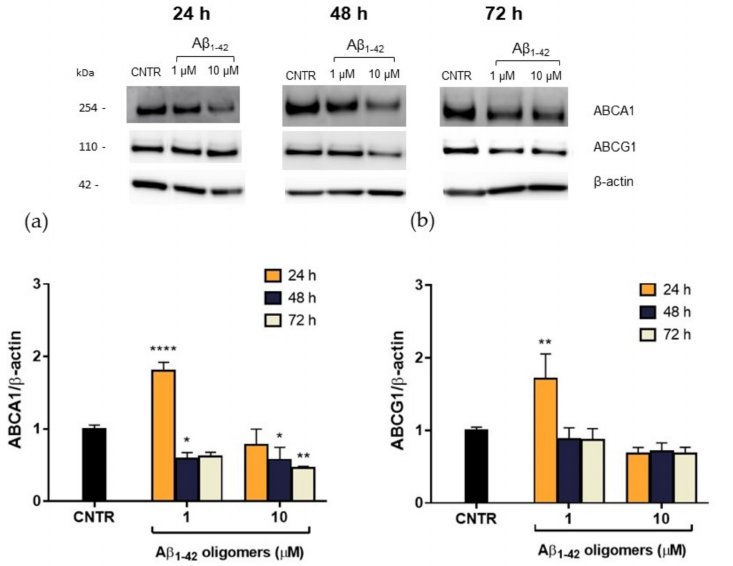
Figure 6. Quantification of ABCA1/ABCG1 expression levels in NHA after exposure to A β 1-42 oligomers via SDS-PAGE/WB. NHA cells were treated with increasing concentrations (1 µ M, 10 µ M) of oligomers-enriched A β 1-42 samples for 24, 48, or 72 h, and ABCA1 ( a ) and ABCG1 ( b ) levels were evaluated. The data are expressed as the mean of the samples in triplicate ± SEM; * p < 0.05; ** p < 0.01; **** p < 0.0001 (two-way